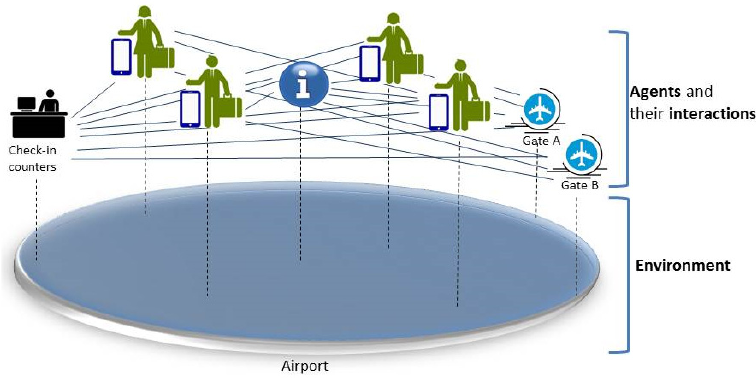
Figure 6. Example of Agent-Based Modeling system structure.